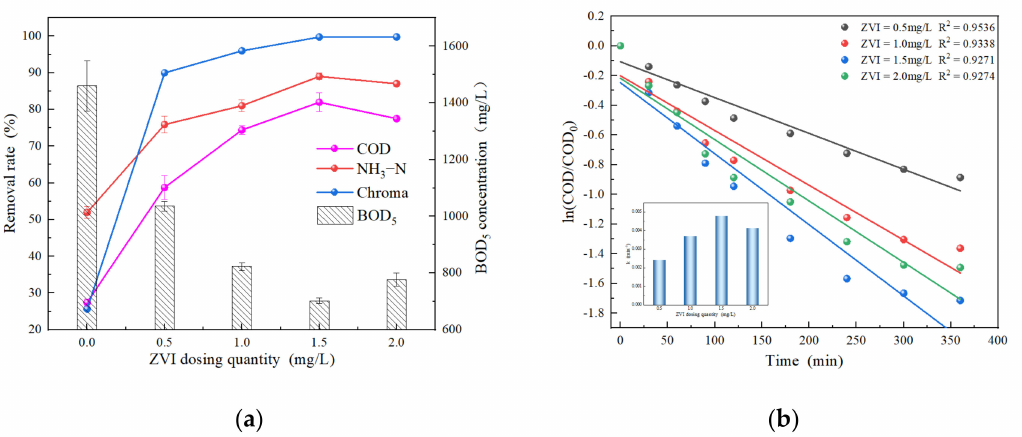
Figure 4. ( a ) Effects of ZVI dosage on COD, NH 3 -N, chroma removal, and BOD 5 content. ( b ) Pseudo-first-order kinetic models of COD degradation at different ZVI dosage levels. (Initial pH: 3.0; PS/12COD ratio: 1; ZVI dosage: 1.5 g/L; current density: 62.5 mA/cm 2 ; reaction time: 6 h).